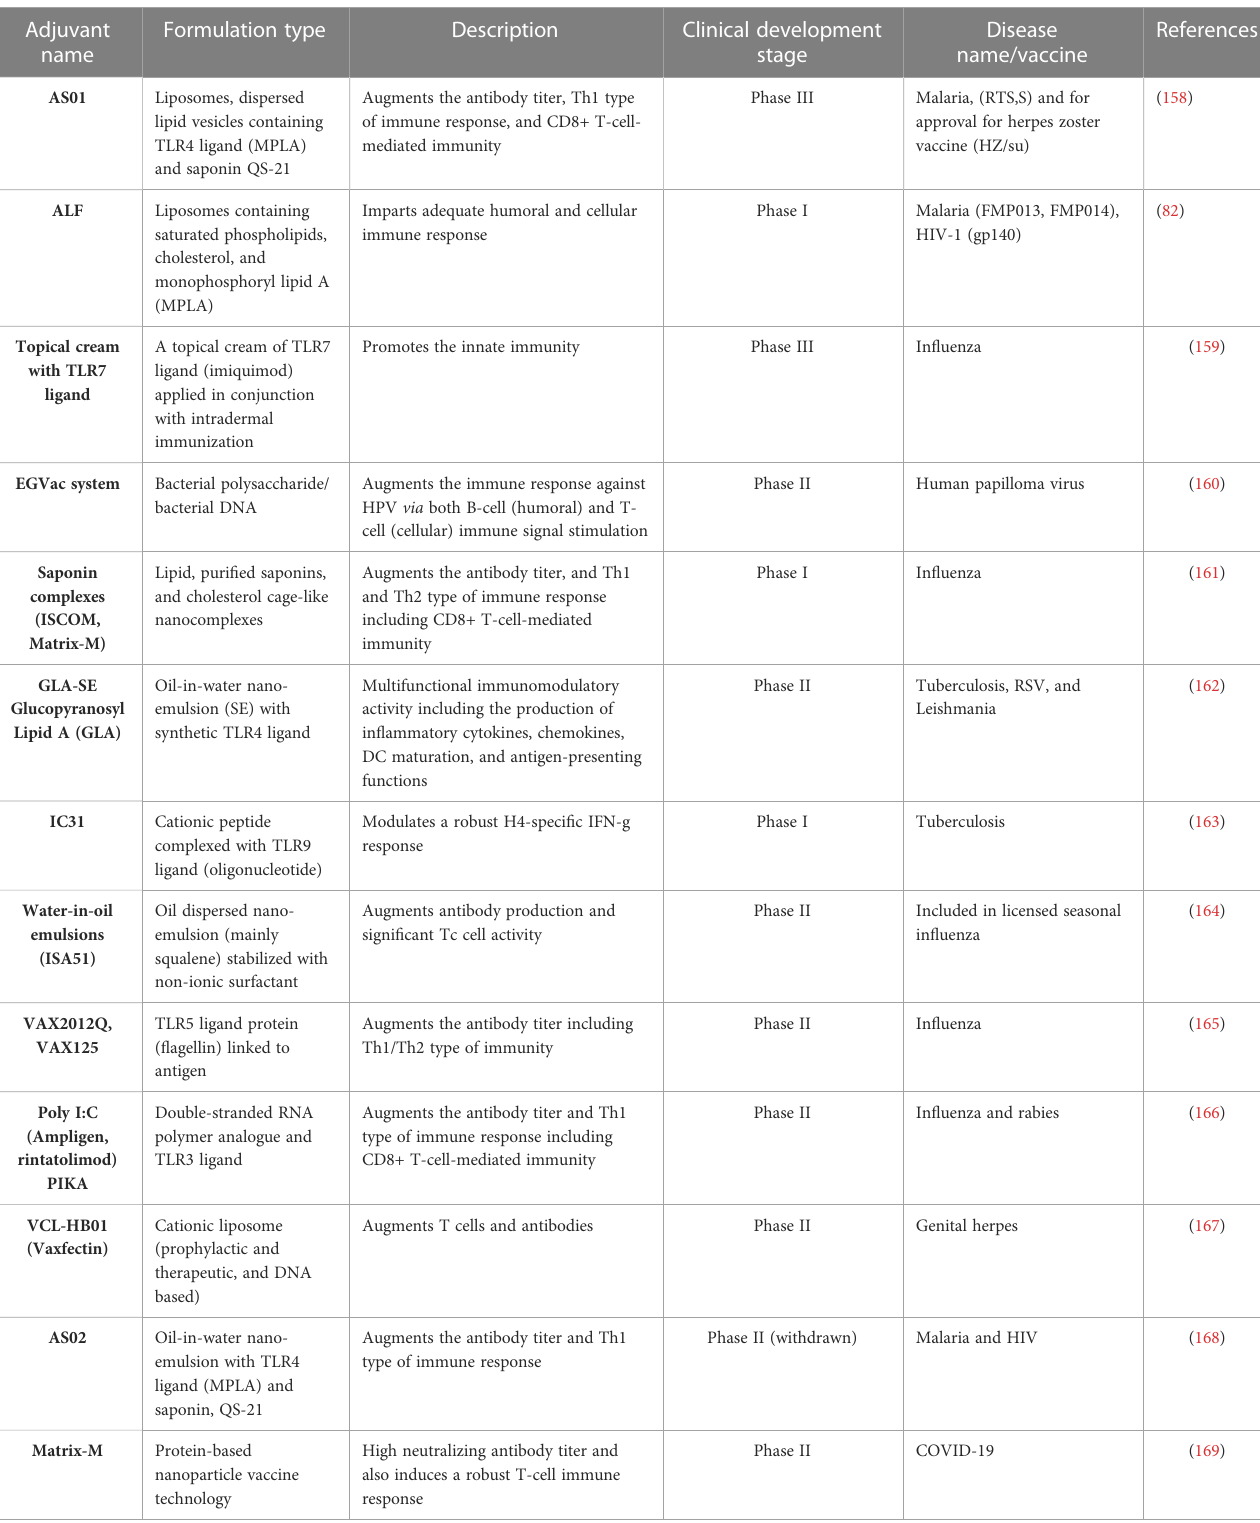
TABLE 2 Vaccine adjuvants in the process of development. Adjuvant